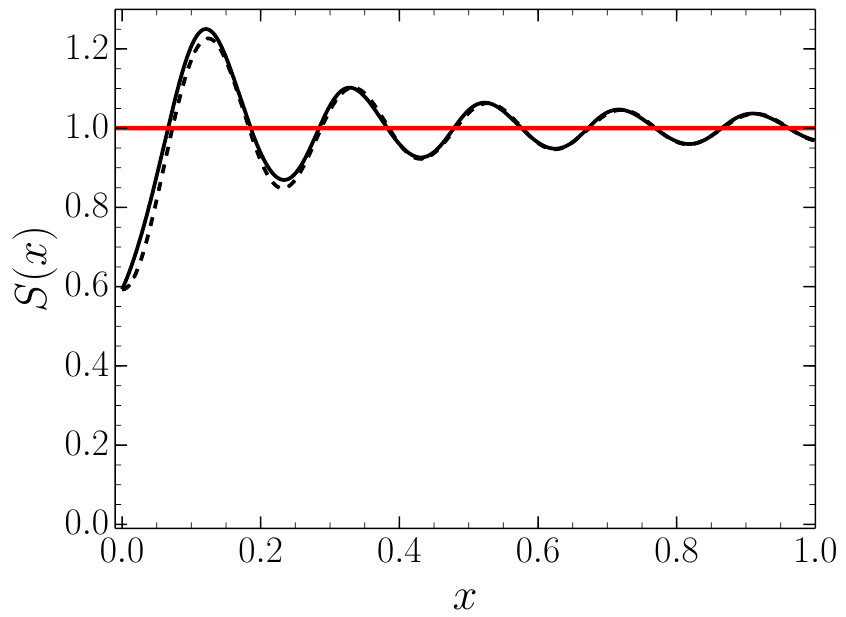
Figure 10. Regge–Wheeler for Schwarzschild: Modified Sanchez approximation . The dashed curve is the model, our Equation (42), the solid curve is the numerical data. The fit is generally quite good and the curves are often indistinguishable to the naked